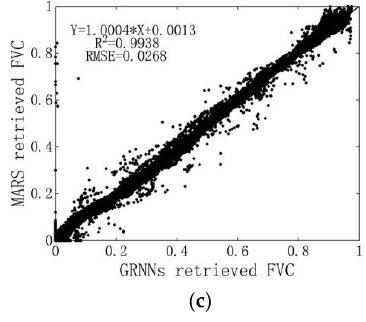
Figure 3. Scatterplots of the comparison results of the fractional vegetation cover (FVC) estimates from the general regression neural networks (GRNNs) with the three other methods: ( a ) back-propagation neural networks (BPNNs); ( b ) support vector regression (SVR); ( c ) multivariate adaptive regression splines (MARS).